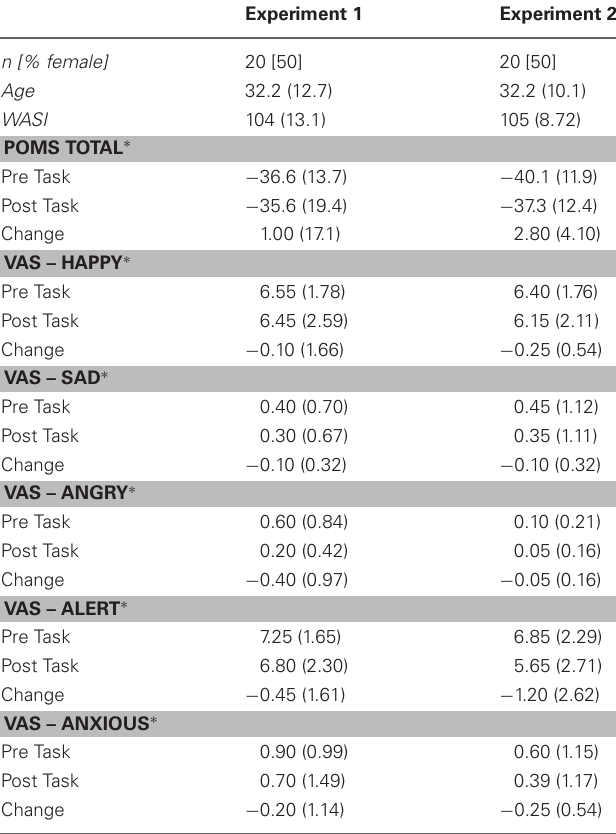
Table 2 | Demographic characteristics and mood ratings for participants in each Experiment.